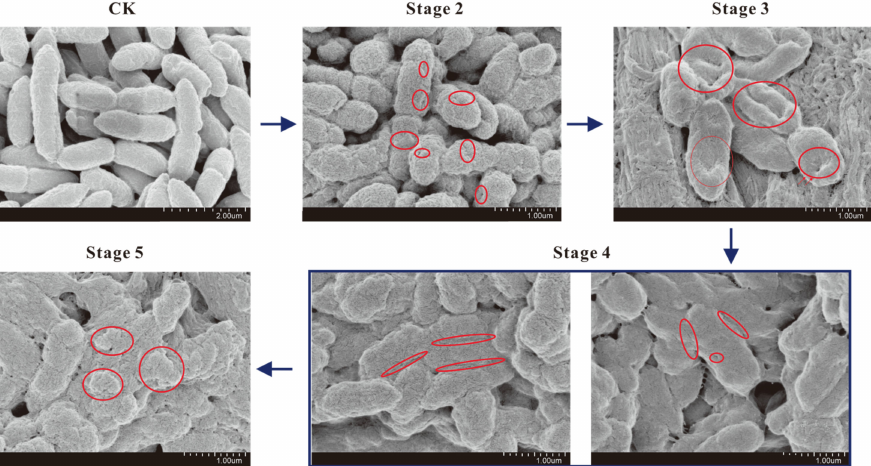
Figure 4. Changes of morphology of A. hydrophila at different treatment stages of LN observed by SEM. The red circles indicated the damage of cell membrane.